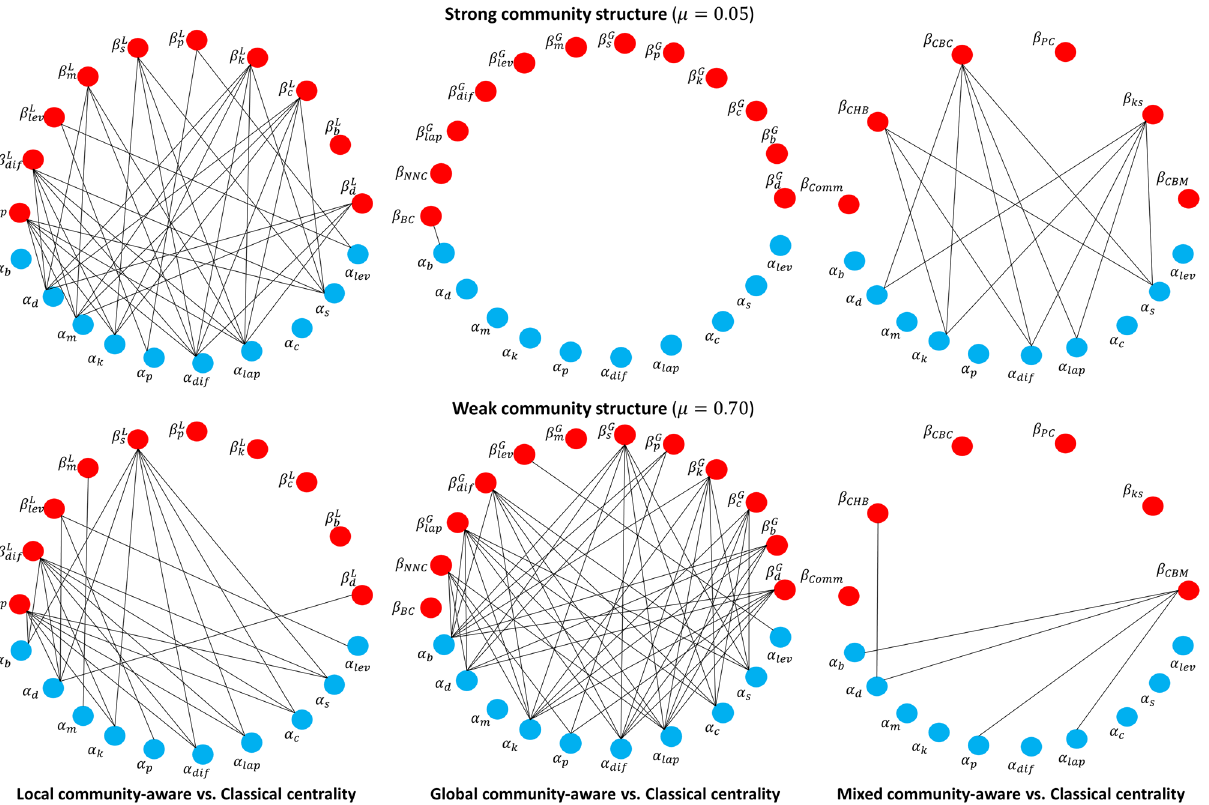
Figure 3. Network visualization of the correlation between classical ( α i ) and community-aware ( β j ) centrality measures. Two nodes are connected if their Kendall’s Tau correlation value is greater than 0.70. The blue nodes represent classical centrality measures. The red nodes represent community-aware centrality measures. The top networks are based on an LFR network generated with a strong community structure ( µ = 0.05). The bottom networks are based on an LFR network generated with a weak community structure ( µ =